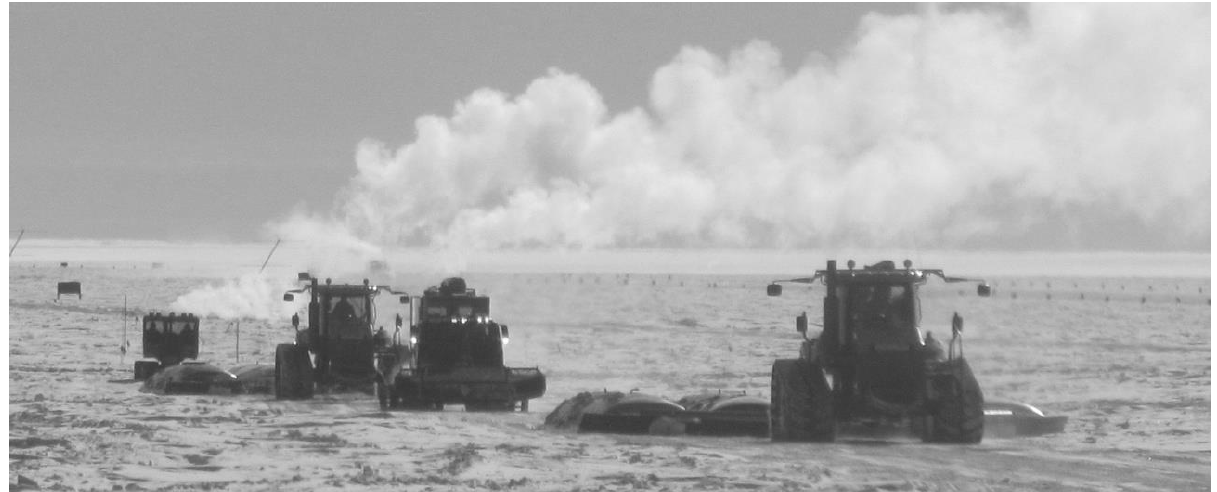
Figure 9: The South Pole Traverse with fuel bladder sleds in tow